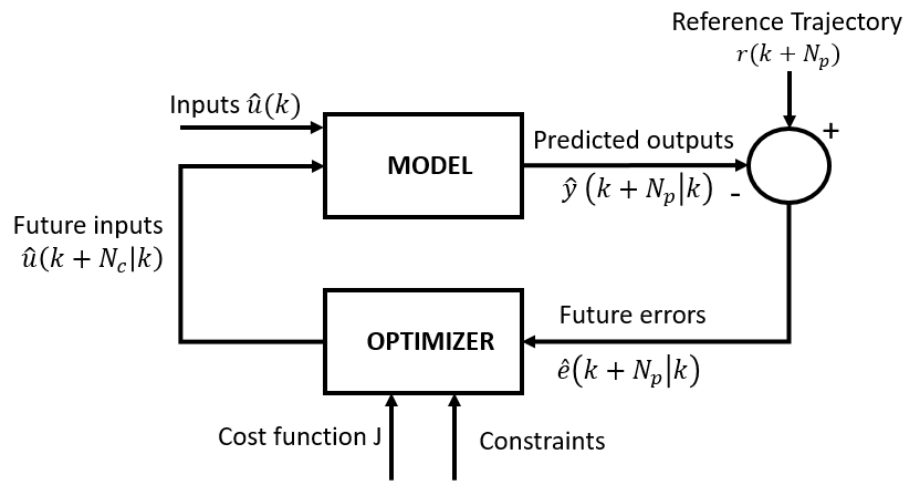
Figure 1. Model predictive controller scheme [22].